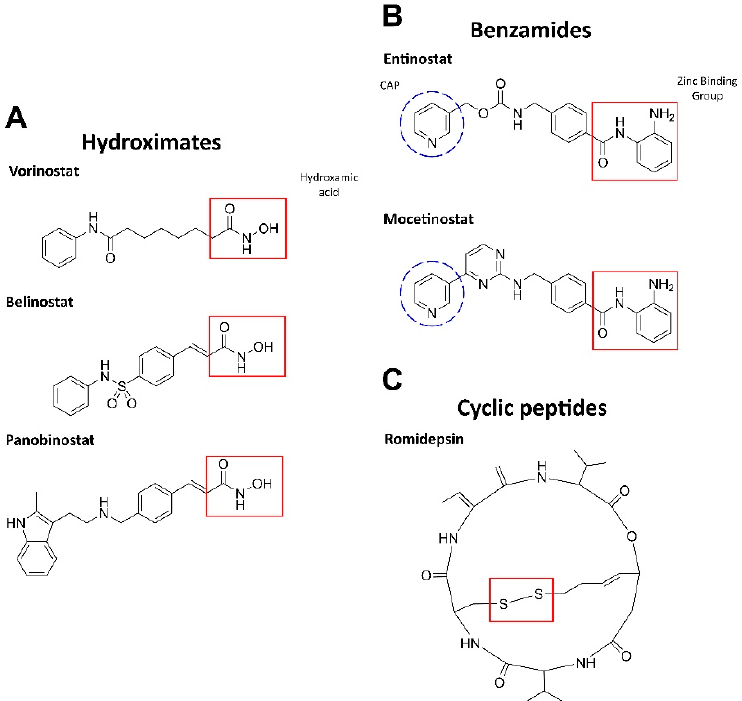
Figure 1. Structures of HDAC inhibitors. ( A ) The active group is hydroxamic acid (red) which binds to the zinc ion in HDAC [24]. ( B ) The zinc-binding moiety is highlighted in red: ortho -NH 2 group and the carbonyl oxygen chelate Zn. CAP is a hydrophobic group for protein surface recognition [34]. ( C ) The disulfide bond in romidepsin is reduced by glutathione to form an active compound. The reduced romidepsin forms a covalent disulfide bond with the sole cysteine residue in the HDAC pocket [35]. The structures were designed by ChemDraw®, a product of PerkinElmer